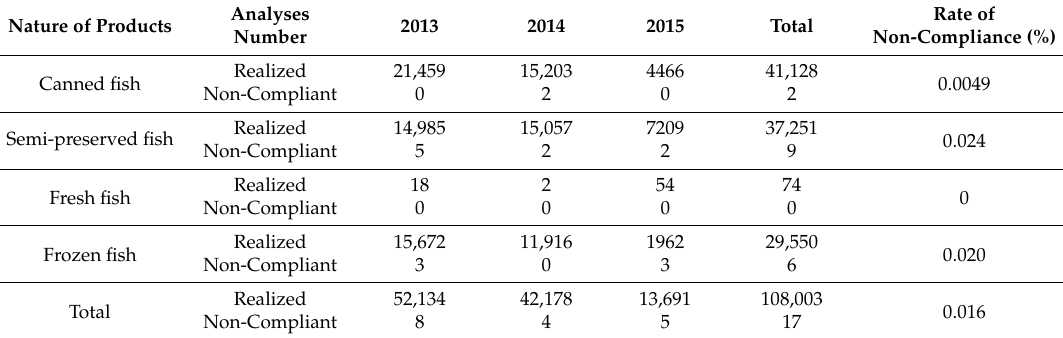
Table 1. Summary of histamine analyses in fishery products